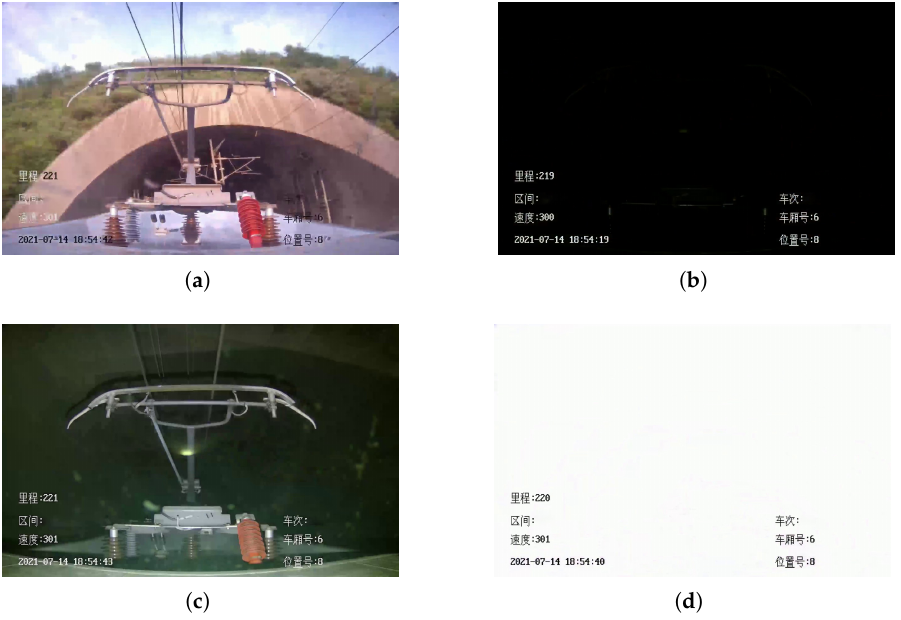
Figure 13. Tunnels affects pantograph detection. ( a ) Before the HSR enters the tunnel. ( b ) The moment the HSR enters the tunnel. ( c ) After the fill light is turned on, the HSR runs stably in the tunnel. ( d ) The moment the HSR exits the tunnel.